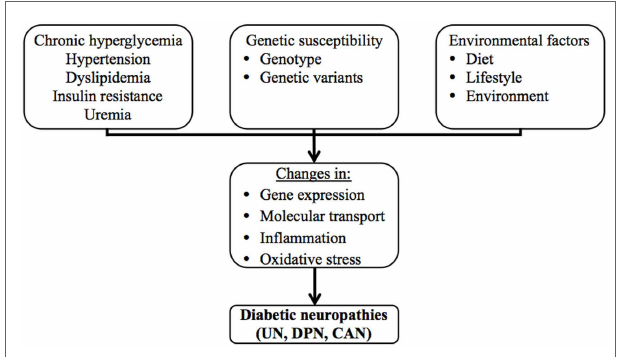
FiguRe 1 | The multifactorial etiology of the diabetic neuropathies